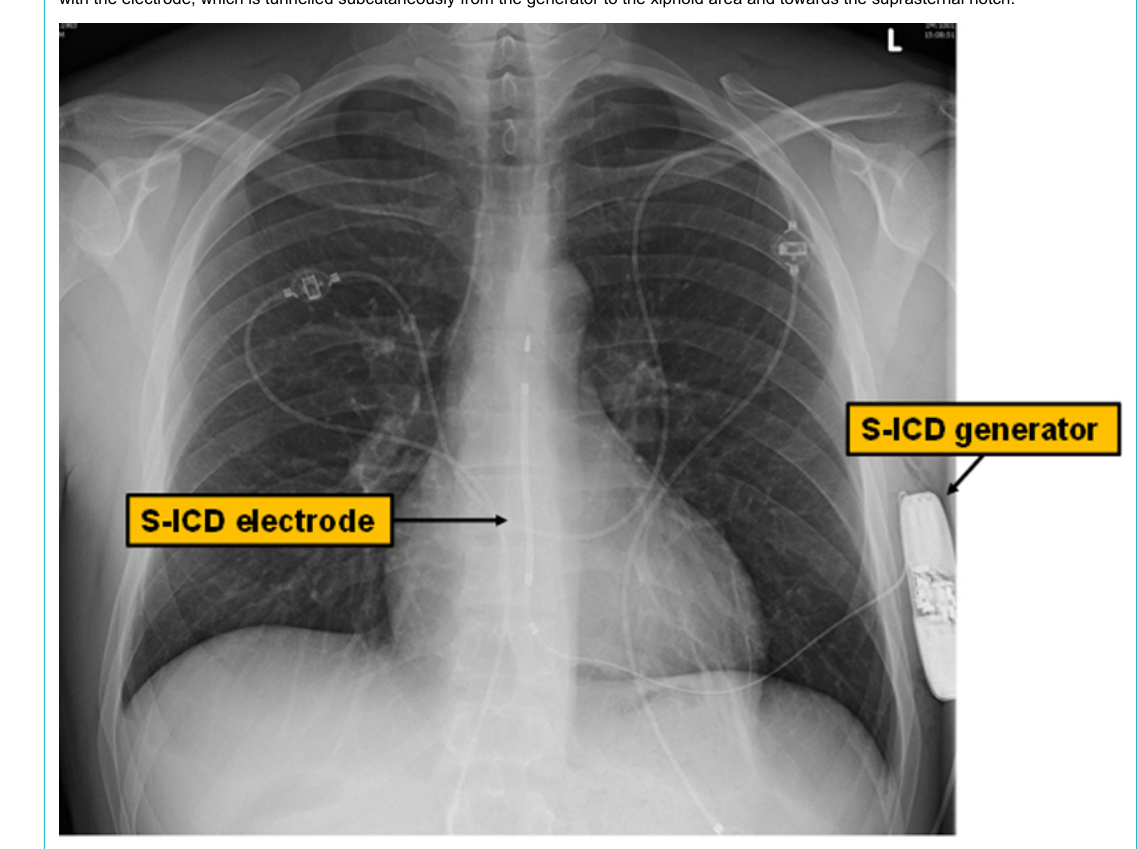
Figure 1: Chest X-ray of a male patient after S-ICD implantation. The generator of the S-ICD is shown on the left side of the patient together with the electrode, which is tunnelled subcutaneously from the generator to the xiphoid area and towards the suprasternal